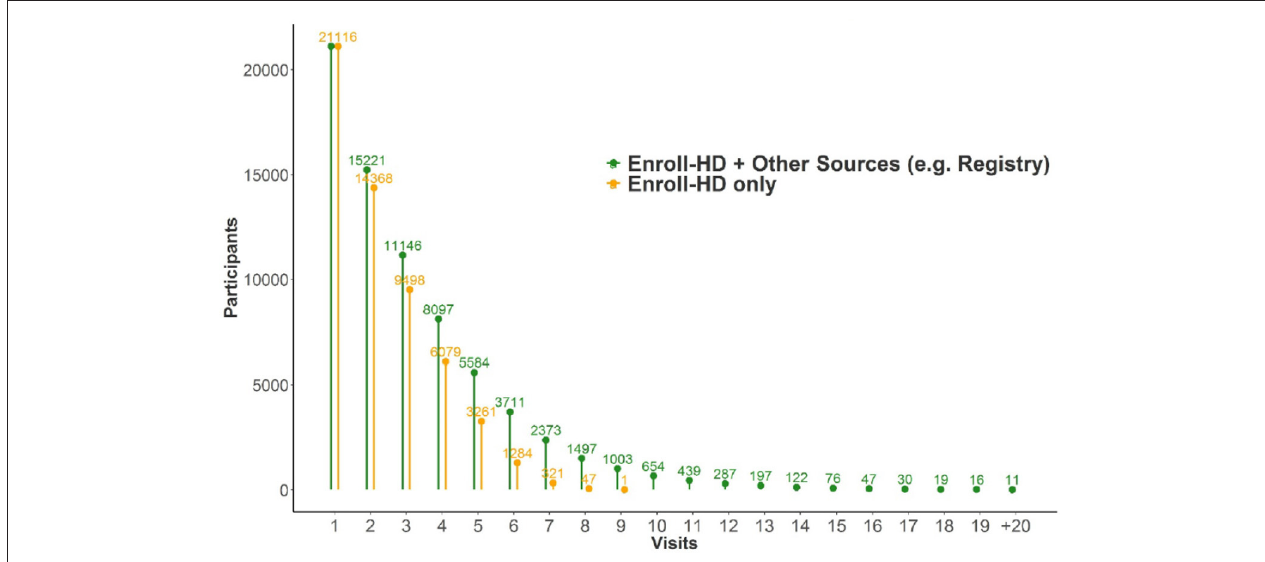
FIGURE 2 | Number of participants from Enroll-HD alone and in combination with precursor studies like REGISTRY with specified number of visits ( N = 21,116).